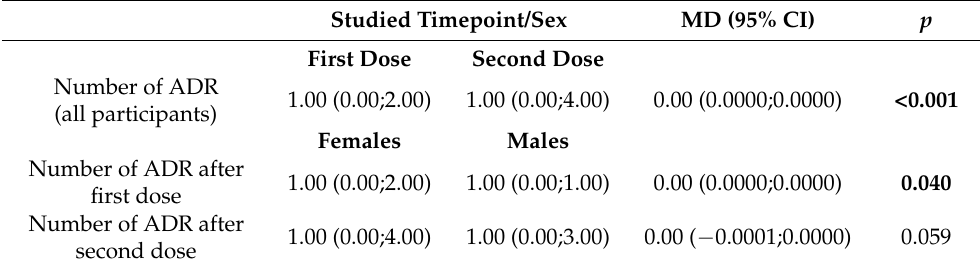
Table 2. Comparison of a number of ADR between first and second